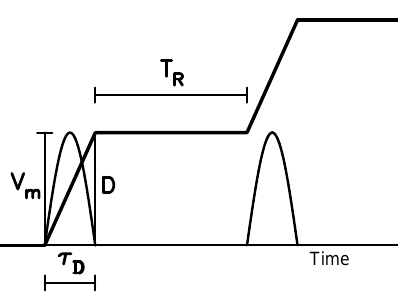
Figure 1. A general pattern of time variations in slip (thick solid line) and particle velocity (thin solid curve) during a seismic cycle: T R is the recurrence time or the inter-event time of two events in a seismic cycle; τ D is the duration time of slip of an event; D is the final slip of an event; and V m is the peak particle velocity of an